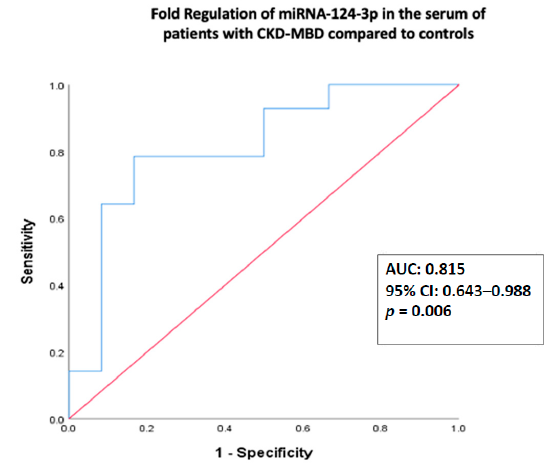
Figure 3. Area under the curve (AUC) of receiver-operating characteristic (ROC) for the relative expression of miRNA-124-3p and ROC curve. AUC, 95% confidence interval (95% CI), and nominal p values are demonstrated. The relative expression of miRNA-124-3p is log-transformed.